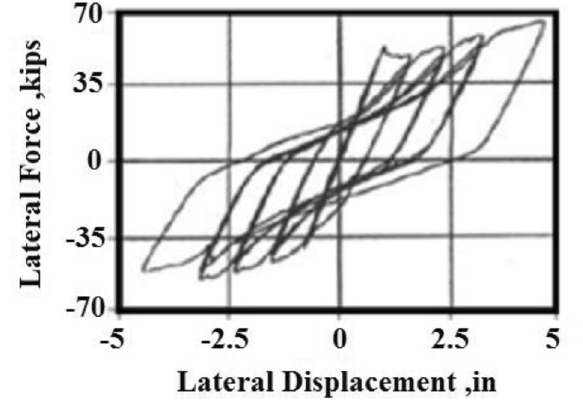
Fig. 2 Hysteresis curve of the special truss frame